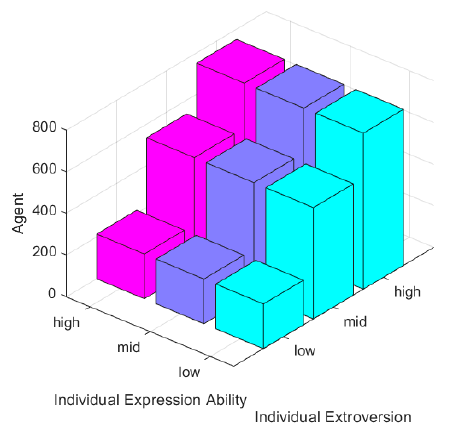
Figure 6. The number of people expressing their attitudes under different individuals’ extroversion and individual expression ability.